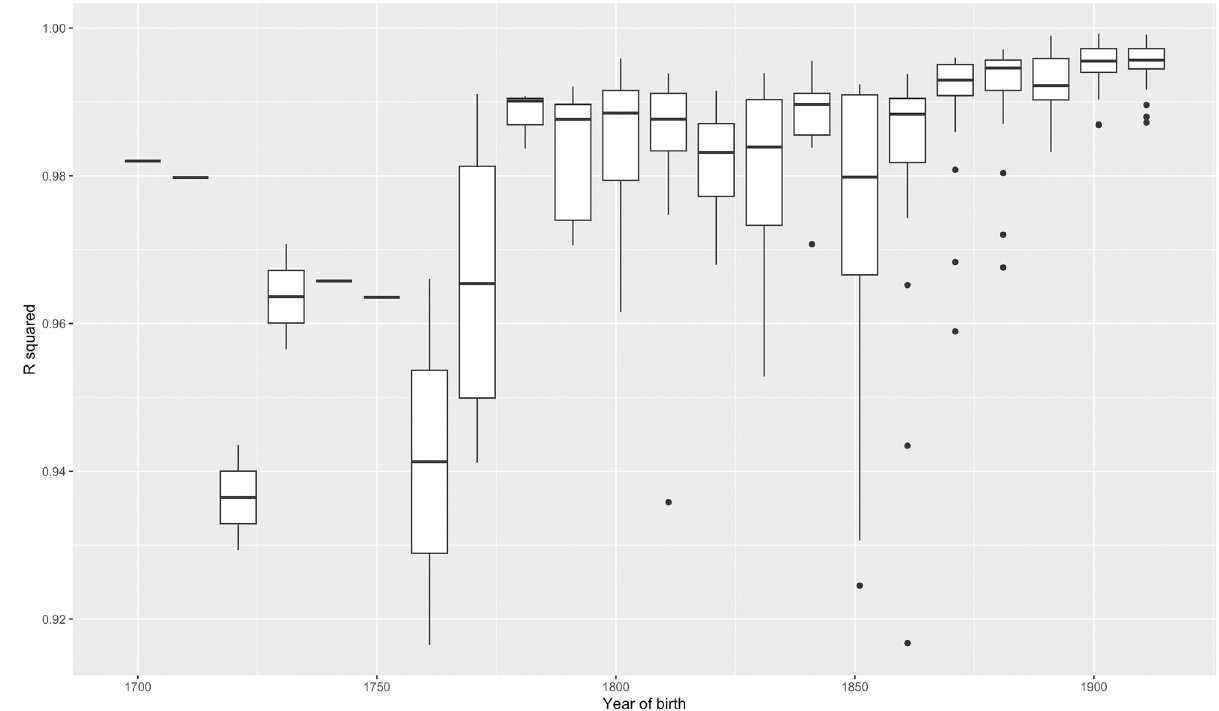
Fig 3. Box-and-whisker plot of the distribution R-squared across extinct cohorts, by decade of birth.